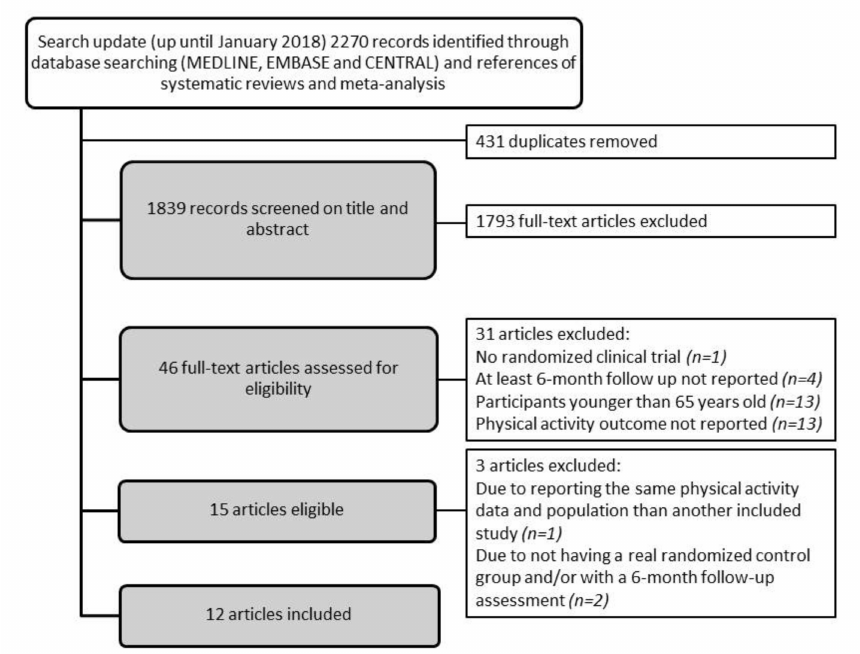
Figure 1. Flow chart of study